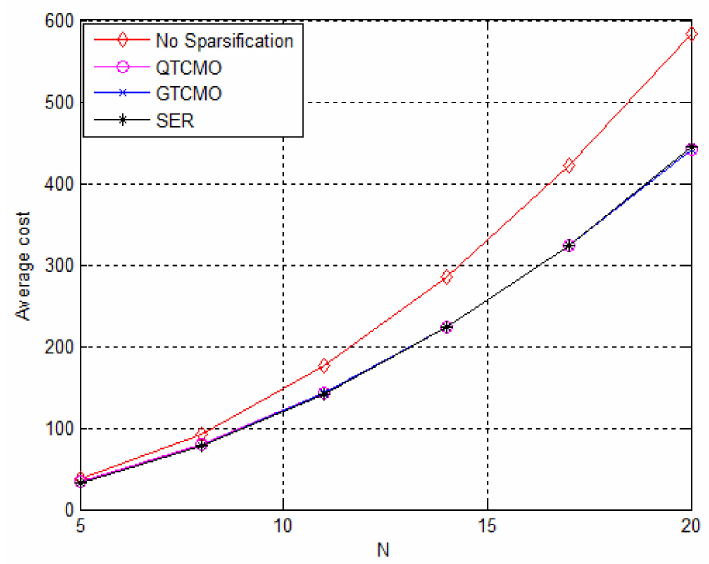
Figure 7. The LQR cost of the proposed algorithm for different N values.